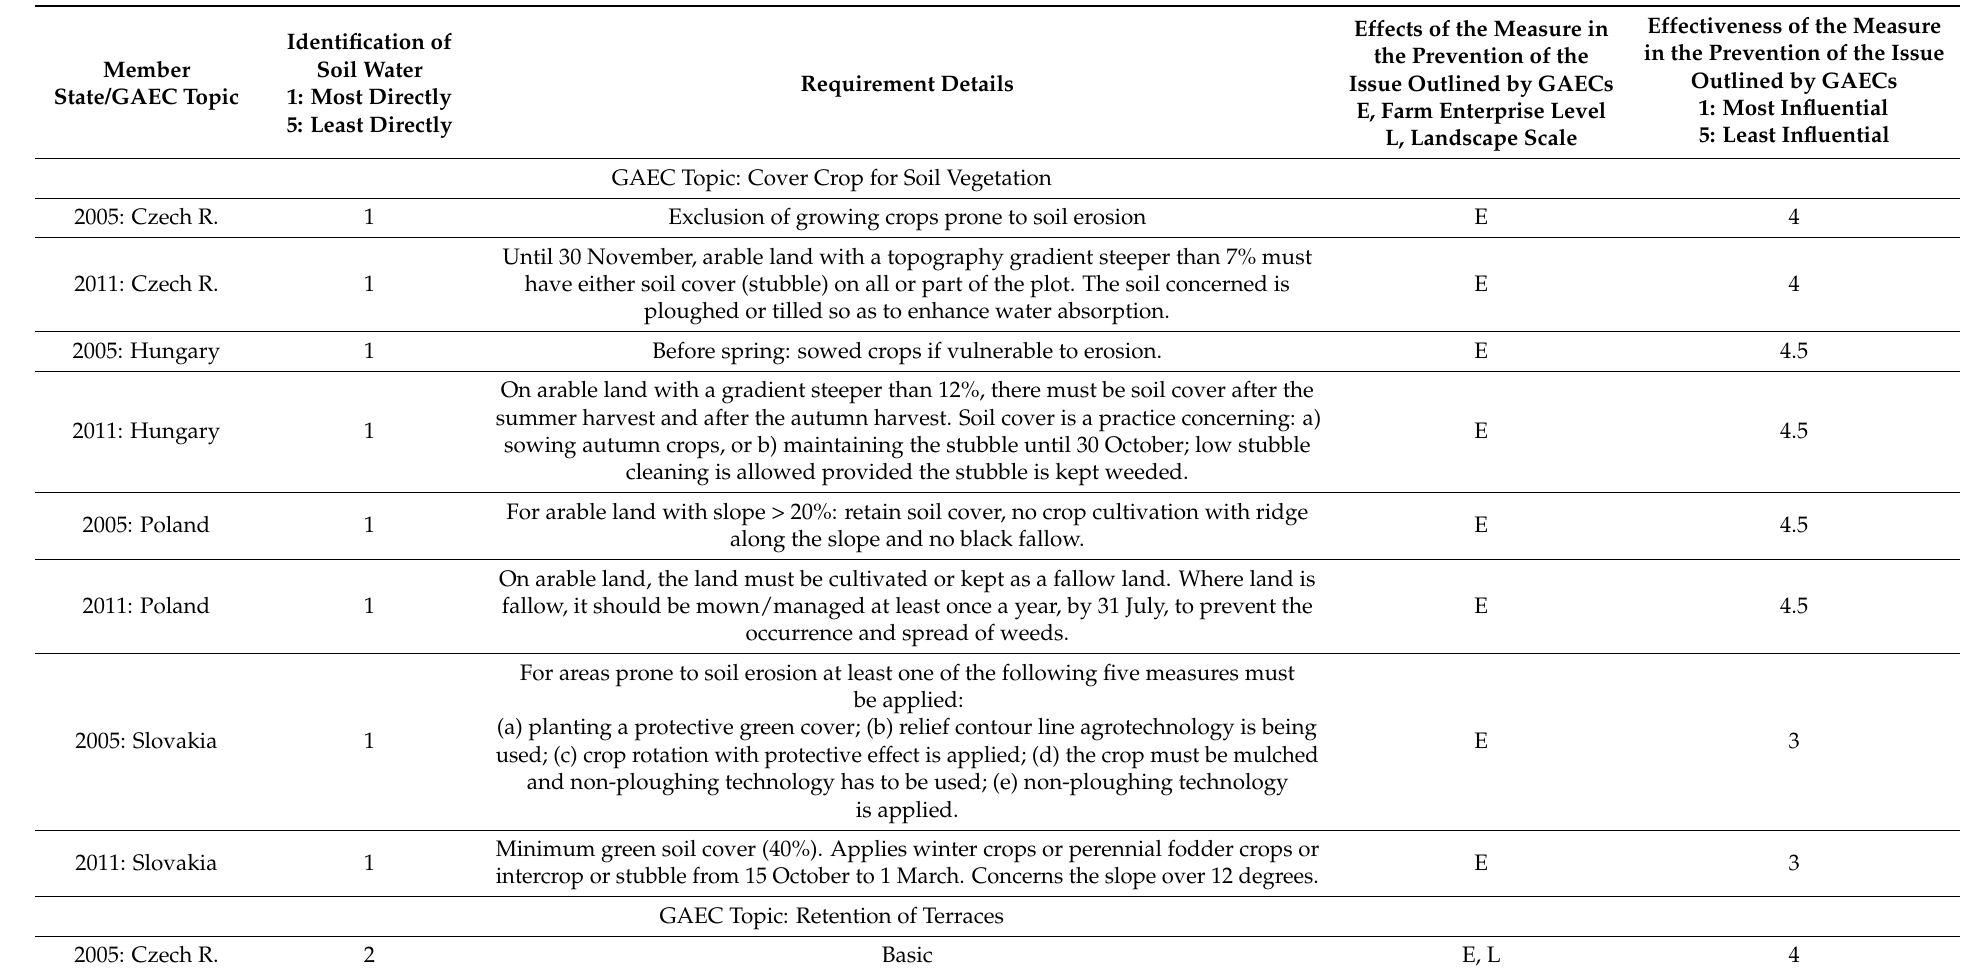
Table 4. Identification of soil-water effects within GAEC